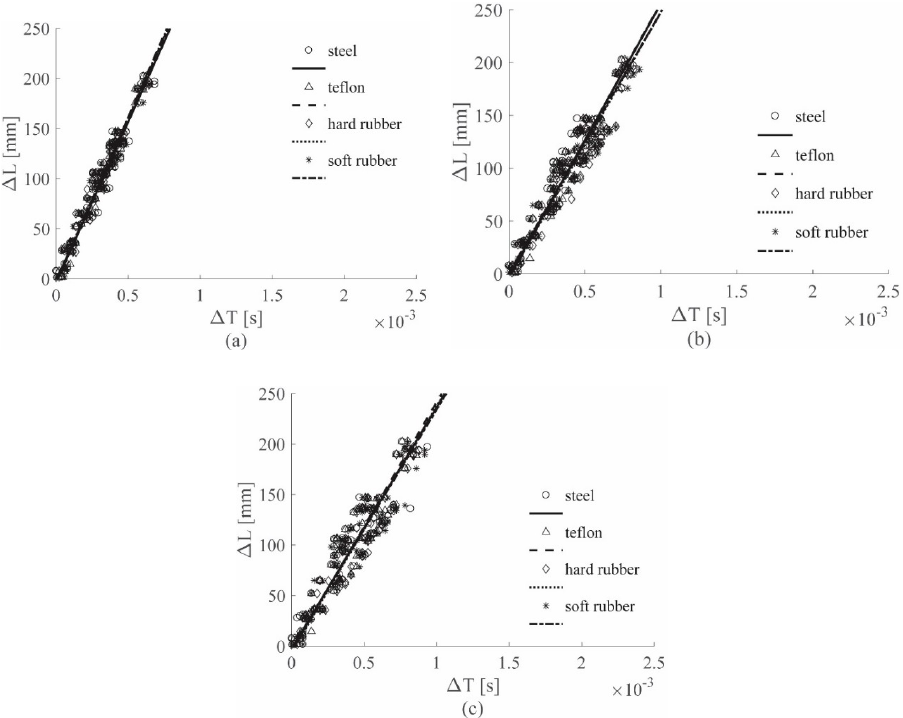
Figure 11. ( Δ L – Δ T ) visual approach results for the ACC sensors, sandwich panel, all tips,